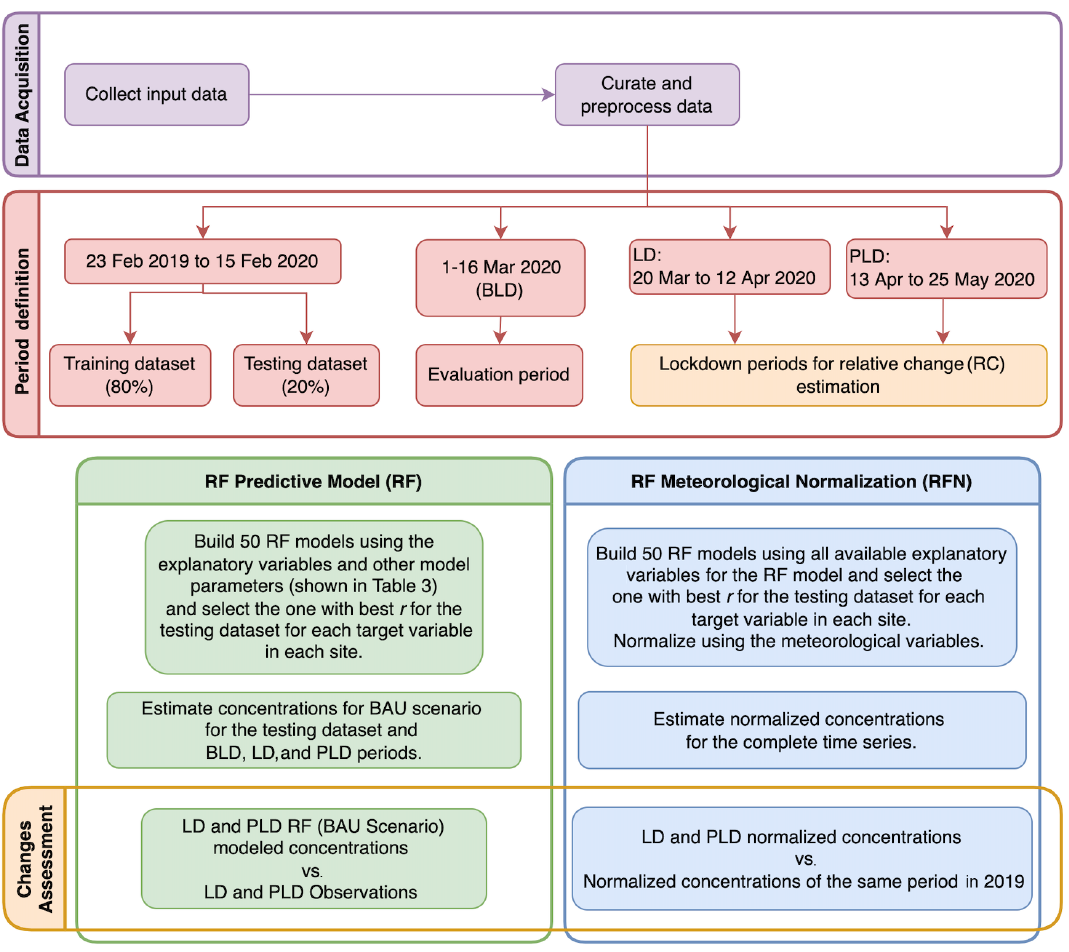
Figure 2. Schematic description of the model building and